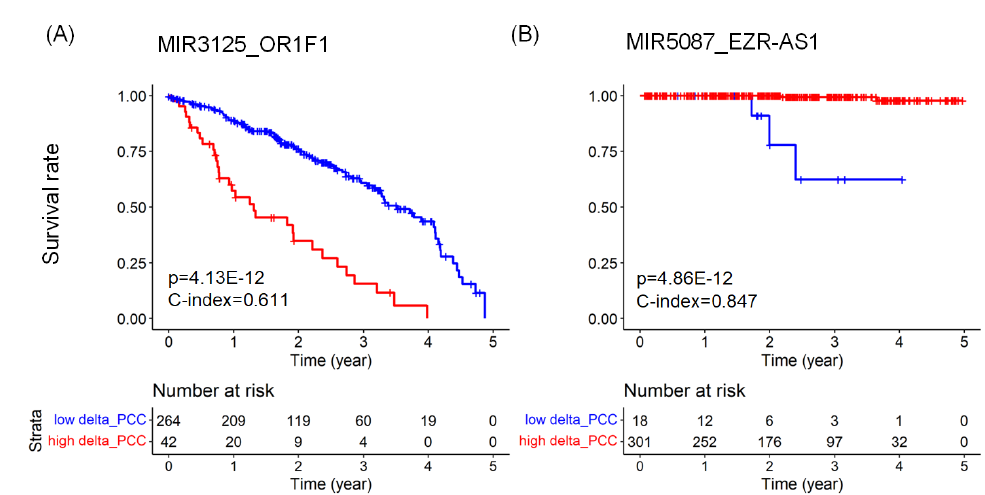
Figure 2. Kaplan–Meier plots comparing the survival rates of two groups of cancer patients with respect to a miRNA–RNA pair. ( A ) The survival rates of two groups of LUAD patients with respect to MIR3125_OR1F1. The larger | ∆ PCC | values of the MIR3125_OR1F1 pair are associated with the shorter survival rates of LUAD patients. ( B ) The survival rates of two groups of PRAD patients with respect to MIR5087_EZR-AS1. The larger | ∆ PCC | values of the MIR5087_EZR-AS1 pair are associated with the longer survival rates of PRAD patients. The risk tables below the Kaplan–Meier plots show the numbers at risk of each group over five